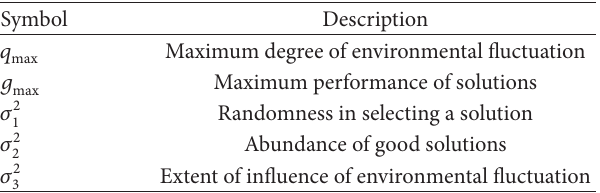
Table 3: Parameters of analytical